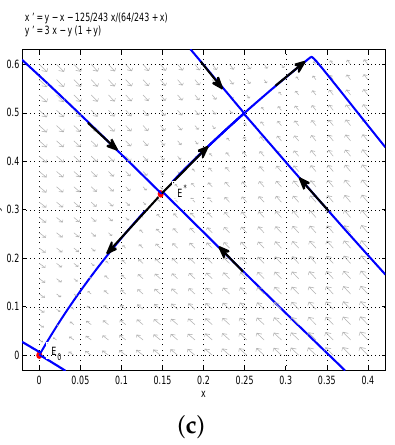
Figure 1. ( a ) ∆ ( b ) < 0. The coexistence of three internal equilibria and one boundary equilibrium when b < c ( e − a ) : two stable nodes E 1 and E 3 andtwo saddles E 0 and E 2 . ( b ) ∆ ( b ) = 0, ˜ A > 0. Two internal equilibria when b < c ( e − a ) : a stable node E 1 ( E 3 ) and a saddle node E ∗ . ( c ) ∆ ( b ) = 0, ˜ A = 0. E ∗ is the only internal equilibrium, and it is the saddle